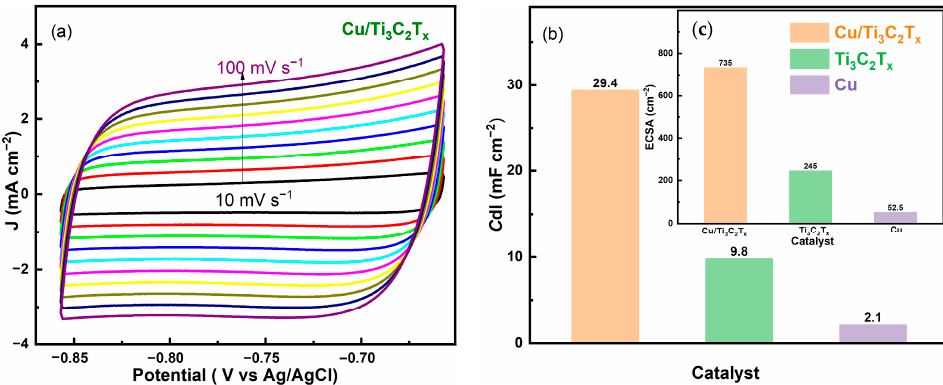
Figure 8. HER performance of Ti 3 C 2 T x , Cu and Cu/Ti 3 C 2 T x series catalysts: ( a ) CV curves of Cu/Ti 3 C 2 T x at the scan rate of 10, 20, 30, 40, 50, 60, 70, 80, 90, 100 mV s − 1 , ( b ) comparisons of C dl, ( c ) comparisons of ECSA.